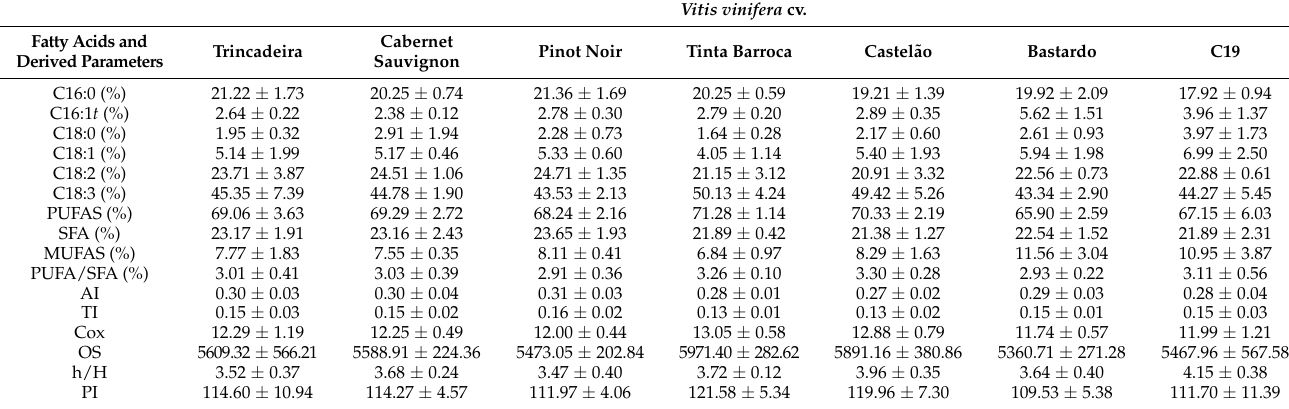
Table 4. Grapevine leaves FA composition: polyunsaturated FA (PUFAs); saturated FA (SFAs); monounsaturated FA (MUFAs); palmitic acid (C16:0); trans -hexadecaenoic acid (C16:1 t ); stearic acid (C18:0); oleic acid (C18:1); linoleic acid (C18:2); α -linolenic acid (C18:3); and indexes of lipid nutritional quality: atherogenic index (AI), thrombogenic index (TI), oxidisability (Cox), oxidative susceptibility (OS), hypocholesterolemic/hypercholesterolemic (h/H) and peroxidisability (PI). N =